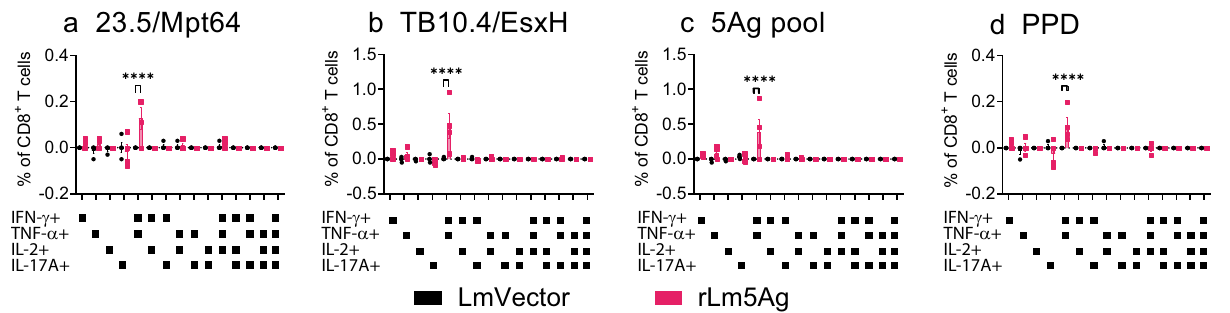
Fig. 5 Frequency of polyfunctional cytokine-expressing CD8 + T cells in the lungs of C57BL/6 mice immunized three times with LmVector or rLm5Ag. C57BL/6 mice ( n = 4/group, the same mice as shown in Fig. 2) were immunized three times s.q. with LmVector (black) or rLm5Ag (pink) at Weeks 0, 4, and 8. One week after the last immunization, animals were euthanized and their lung cells processed as described in the legend to Fig. 2. The lung cells were stimulated with individual proteins of 23.5/Mpt64 ( a ) or TB10.4/EsxH ( b ), or pool of 5 antigens (5Ag pool) ( c ) or PPD ( d ), and assayed by intracellular cytokine staining for surface markers of CD4 and CD8 followed by CD3 and intracellular markers of IFN- γ , TNF- α , IL-2, and IL-17A. The frequencies of live CD8 + T cells producing any of the 15 possible combinations of the four cytokines (IFN- γ , TNF- α , IL-2, and IL-17A) were uniquely distinguished by using Boolean gates of FlowJo 10 software, as indicated below each panel. Values are the mean ± SEM. **** P < 0.0001 by two-way ANOVA with Sidak ’ s post multiple comparisons test.